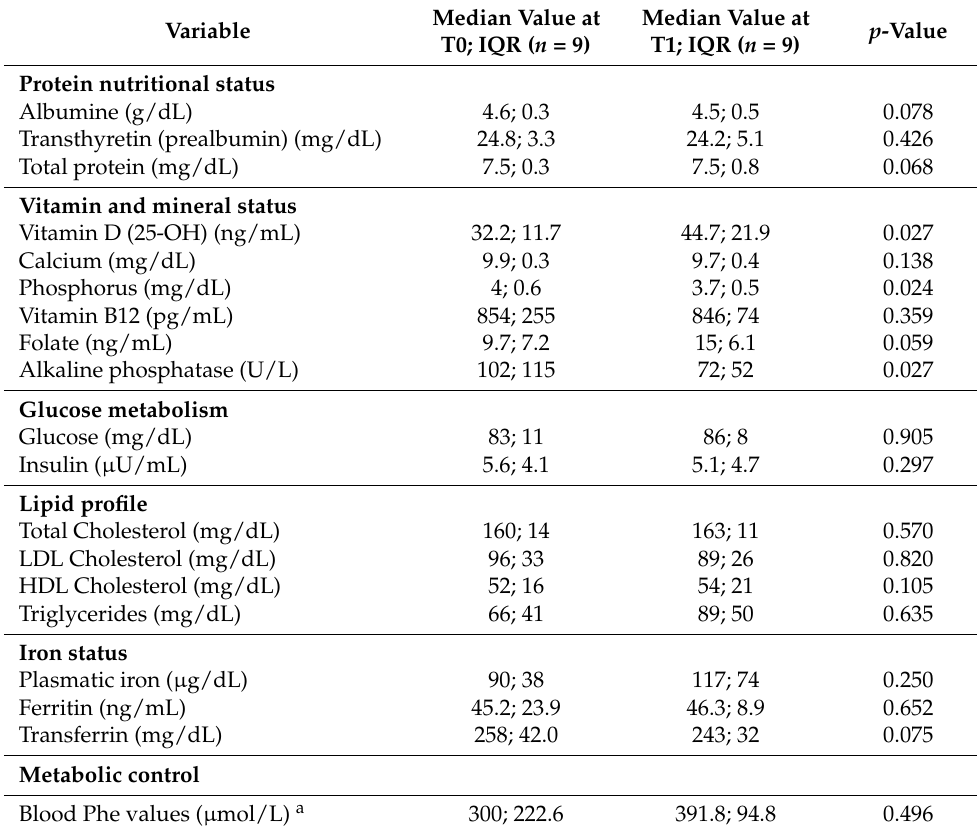
Table 1. Biochemical values at T0 and T1. Amounts are reported as median and interquartile range (IQR) . Statistical significance was determined through a non-parametric Wilcoxon paired signed-rank test; p -values below 0.05 were considered